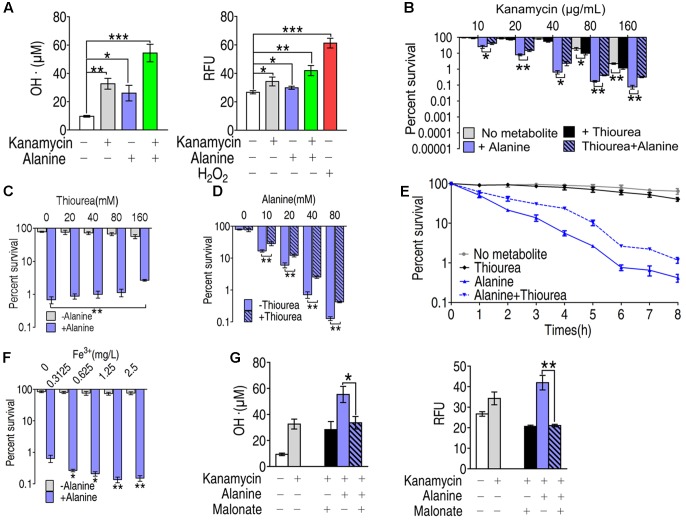
Role of ROS in the synergistic killing of kanamycin with alanine. (A) Hydroxyl radical was quantified in EIB202 in the presence of kanamycin, alanine and/or glucose as indicated by colorimetric method (left panel) and by fluorescence (right panel). (B) Percent survival of EIB202 in the presence of thiourea (160 mM), alanine (40 mM) or both. (C) Percent survival of EIB202 in the presence or absence of thiourea (160 mM) and the indicated concentration of alanine. (D) Percent survival of EIB202 in the presence or absence of alanine and the indicated concentration of thiourea (160 mM). (E) Percent survival of EIB202 in the presence or absence of kanamycin (40 μg/mL), thiourea (160 mM) and alanine (40 mM) at the indicated time point. (F) Percent survival of EIB202 in the presence or absence of alanine and the indicated concentration of Fe3+(C6H10FeNO8). (G) Effect of malonate (20 mM) on hydroxyl radical concentration in the presence or absence of alanine and/or kanamycin by two different assays as by colorimetric method (left panel) and fluorescence (right panel). ∗p < 0.05, ∗∗p < 0.01, and ∗∗∗p < 0.001 as determined by Student’s t-test.